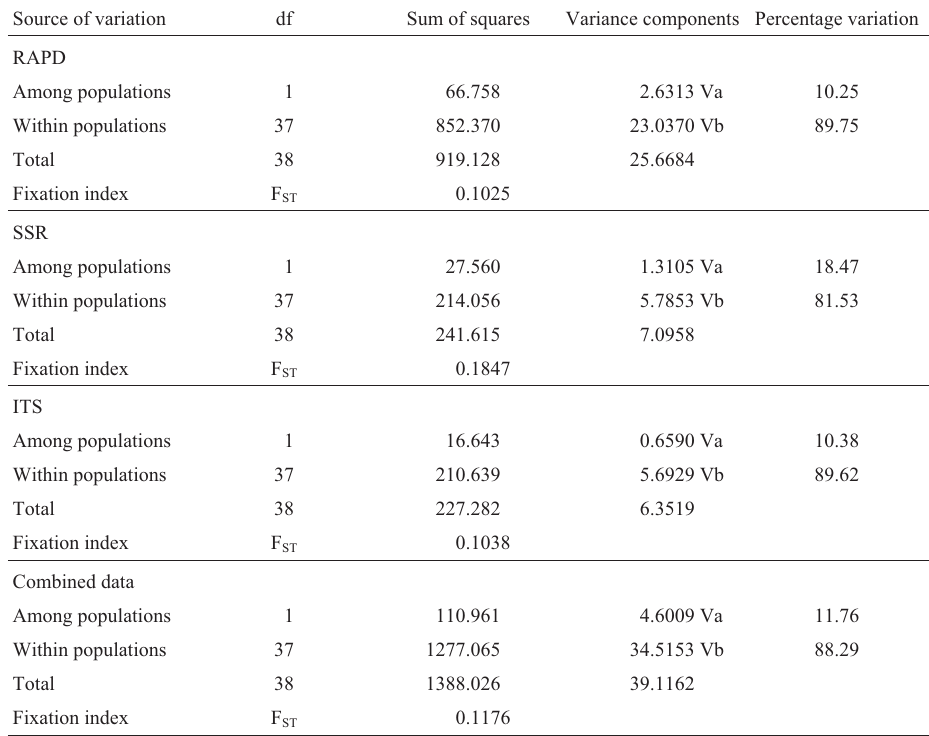
Table 2 - Analysis of molecular variance (AMOVA) results and fixation index (F ST (cid:3) ) of the random amplified polymorphic DNA (RAPD), simple se- quence repeat (SSR), internal transcribed spacer (ITS) and combined (RAPD-SSR-ITS) data for Chilean isolates (n = 39. degrees of freedom (df) = n-1) of M. anisopliae var. anisopliae .